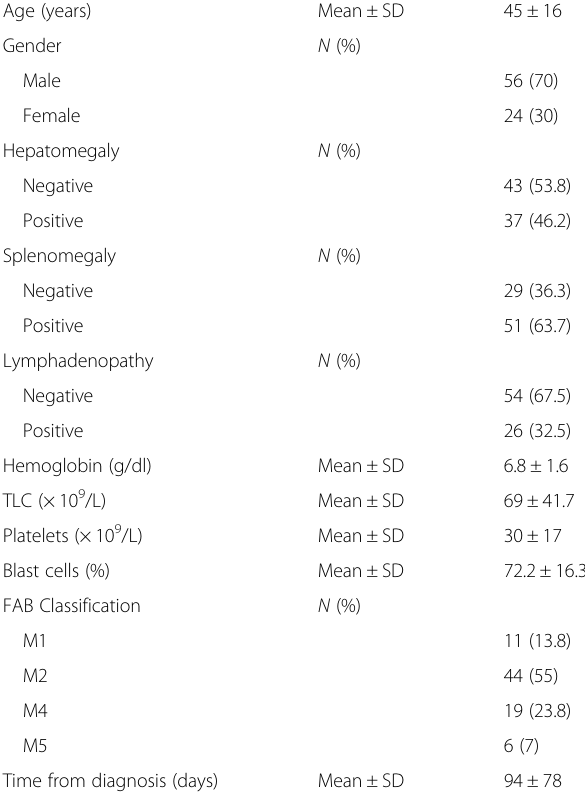
Table 2 Baseline demographic, clinical and